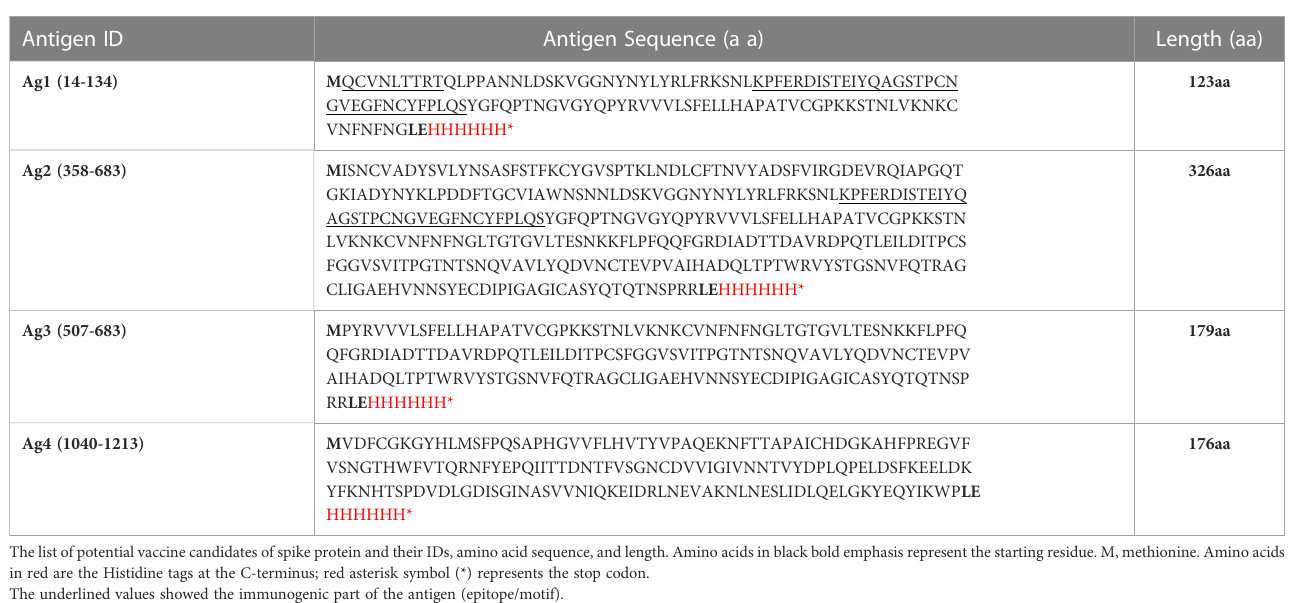
TABLE 1 Amino acid sequence of four spike